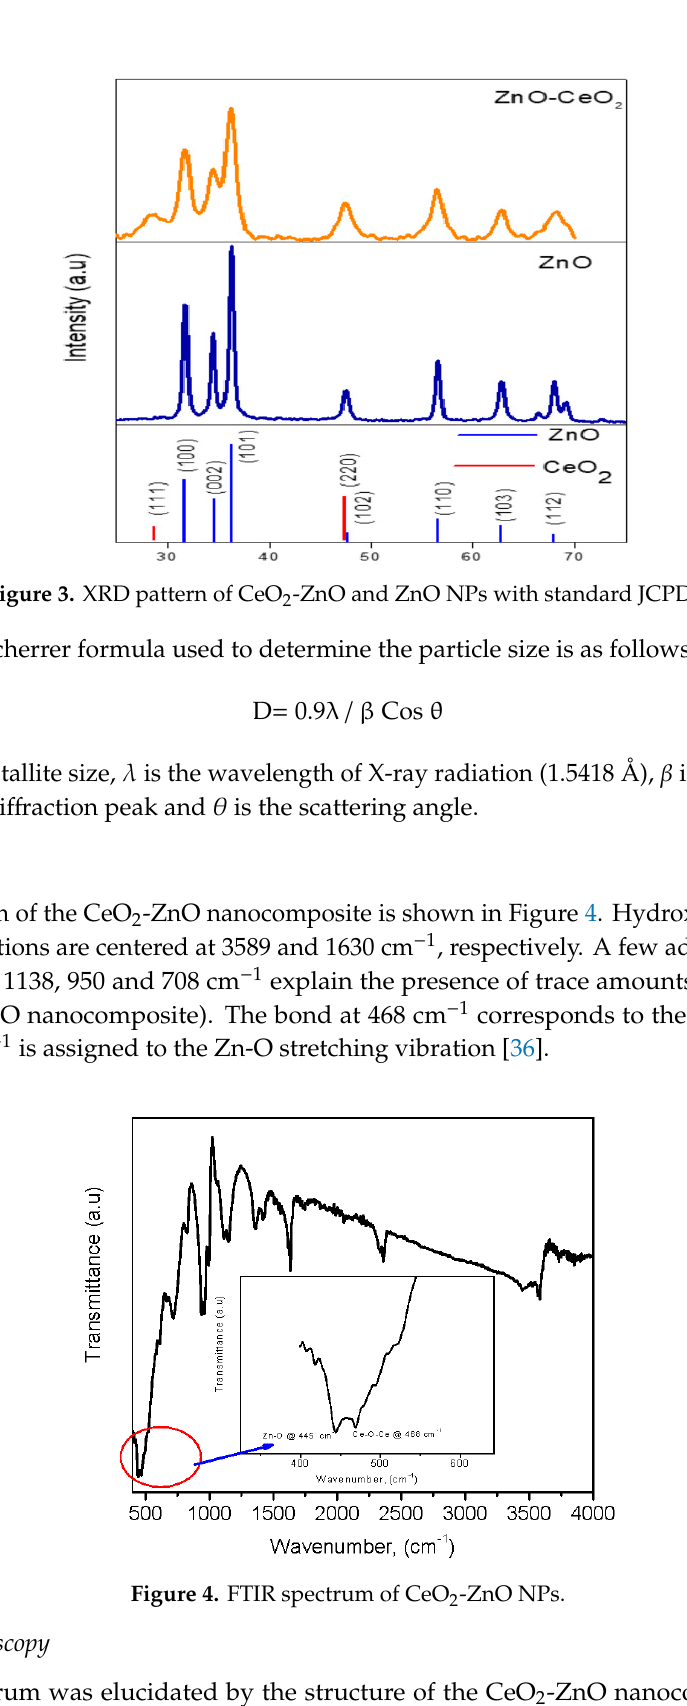
Figure 5. Raman spectrum of CeO 2 -ZnO NPs. 3.4. Optical Properties The UV–Vis DRS of the synthesized ZnO NPs and CeO 2 -ZnO nanocomposite is shown in Figure 6. The strong band at 333 and 373 nm is attributed to the absorption of the host lattice of ZnO and the CeO 2 -ZnO nanocomposite [26]. The bandgap (E g ) is estimated using the Kubelka–Munk (K–M) theory. The intercept of the tangents of the photon energy versus the [ F ( R ∞ ) h ν ] 1/2 of ZnO and the CeO 2 -ZnO nanocomposite gives the band gap. The K–M function F ( R ∞ ) and photon energy (h ν ) are calculated by the following formula.